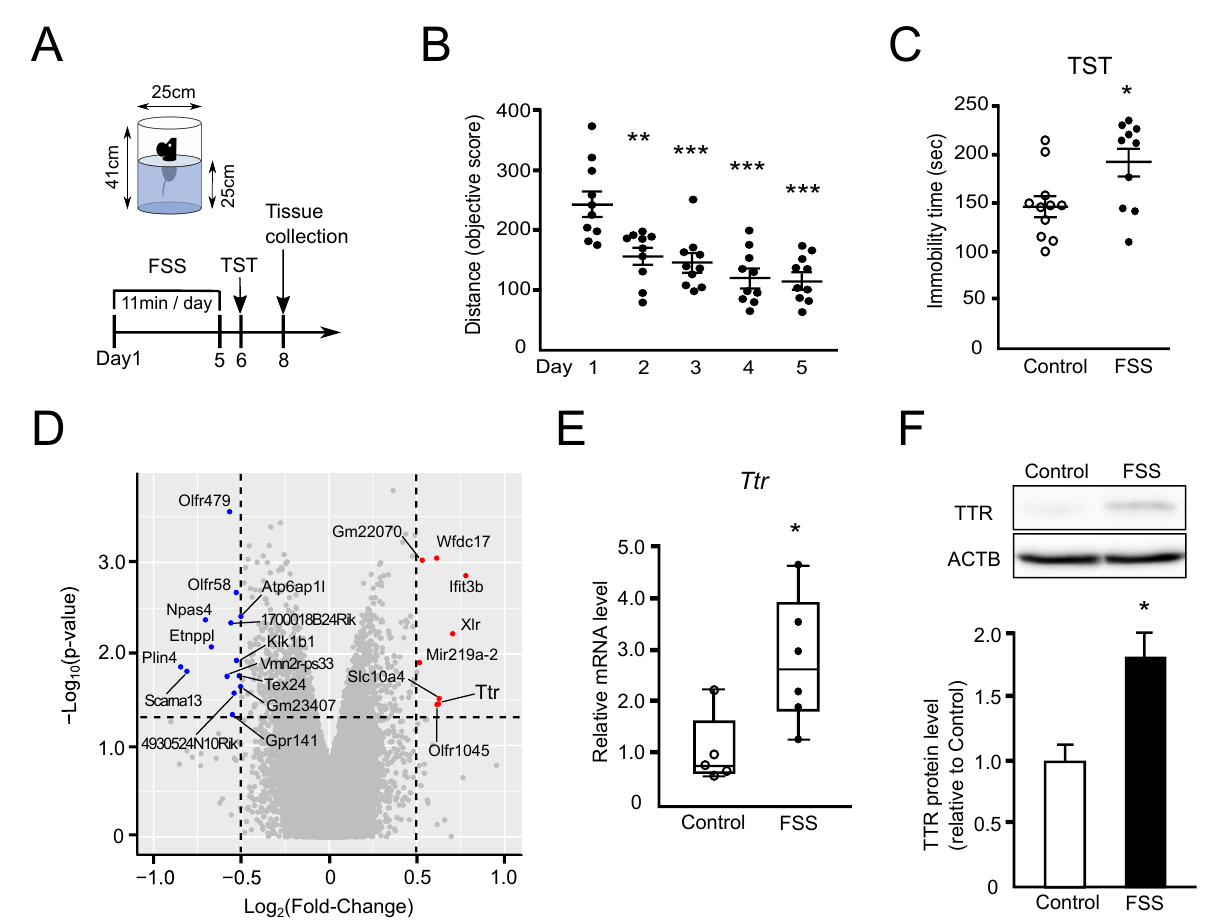
Figure 1. Preparation of forced swim stress (FSS)-induced depression mouse model, behavioral tests, and gene expression analyses. ( A ) Schedule of mouse preparation and analyses. Male B6 mice were loaded with FSS in an acrylic cylinder for 10 min daily for 5 consecutive days. After FSS loading, the mice received the tail suspension test (TST) on Day 6. Then, the hippocampus from male B6 mice was collected on Day 8 for gene expression analyses. ( B ) Moving distance of the mice during FSS loading. Values of each individual were plotted, and mean ± SEM per group was also expressed. ** p < 0.01, *** p < 0.001 vs. Day 1. n = 10. ( C ) The immobile time in TST on Day 6. For the control, the time was measured in the nonstressed mice. Values of each individual were plotted, and mean ± SEM per group was also expressed. Control; n = 11, FSS; n = 10. ( D ) Volcano plot representing gene expression changes in the hippocampus of the FSS mice. The fold-change and the significance are converted to Log 2 (Fold-Change) and − Log 10 ( p -value), respectively. The vertical and horizontal dotted lines show the cut-off of Log 2 (Fold-Change) = ± 0.5 and of p = 0.05, respectively. ( E ) Ttr mRNA expression in the hippocampus of FSS mice was quantified by RT-qPCR (n = 5–6). The box represents the 25–75th percentiles, and the median is indicated. The whiskers represent the highest and lowest values. ( F ) TTR protein expression in the hippocampus of FSS mice was analyzed by Western blotting. Data are expressed as mean ± SEM (n = 3). * p <